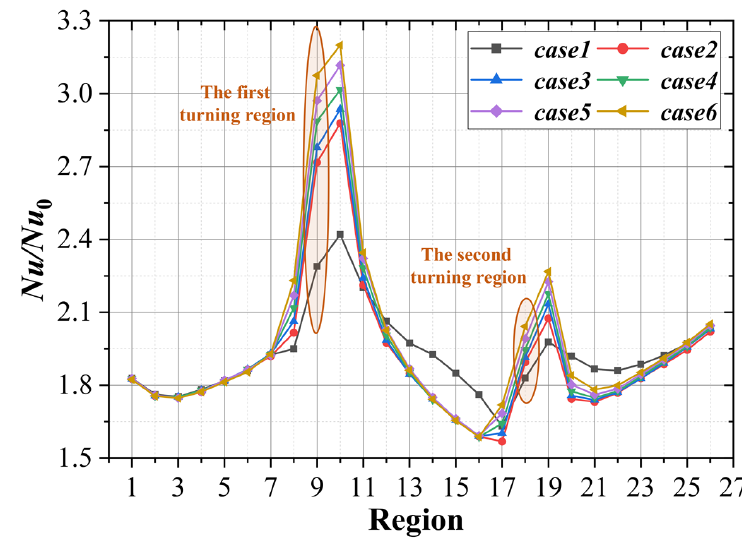
Figure 9. The wall Nu/Nu 0 of SS along the flow direction, Re = 10,000.